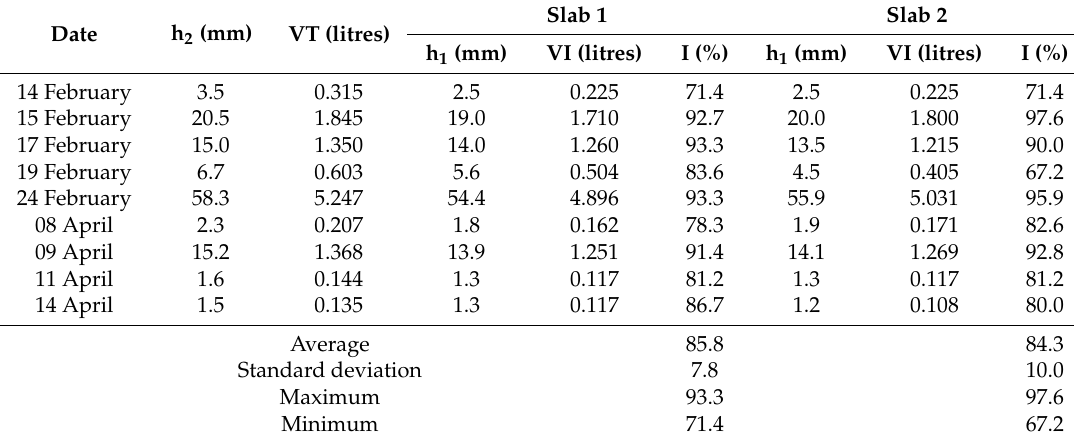
Table 2. Total volume of rain (VT), infiltration volume (VI) and rainwater infiltration (I) for draining asphalt concrete slab 1 (tire rubber without water cycling) and slab 2 (tire rubber with water cycling).